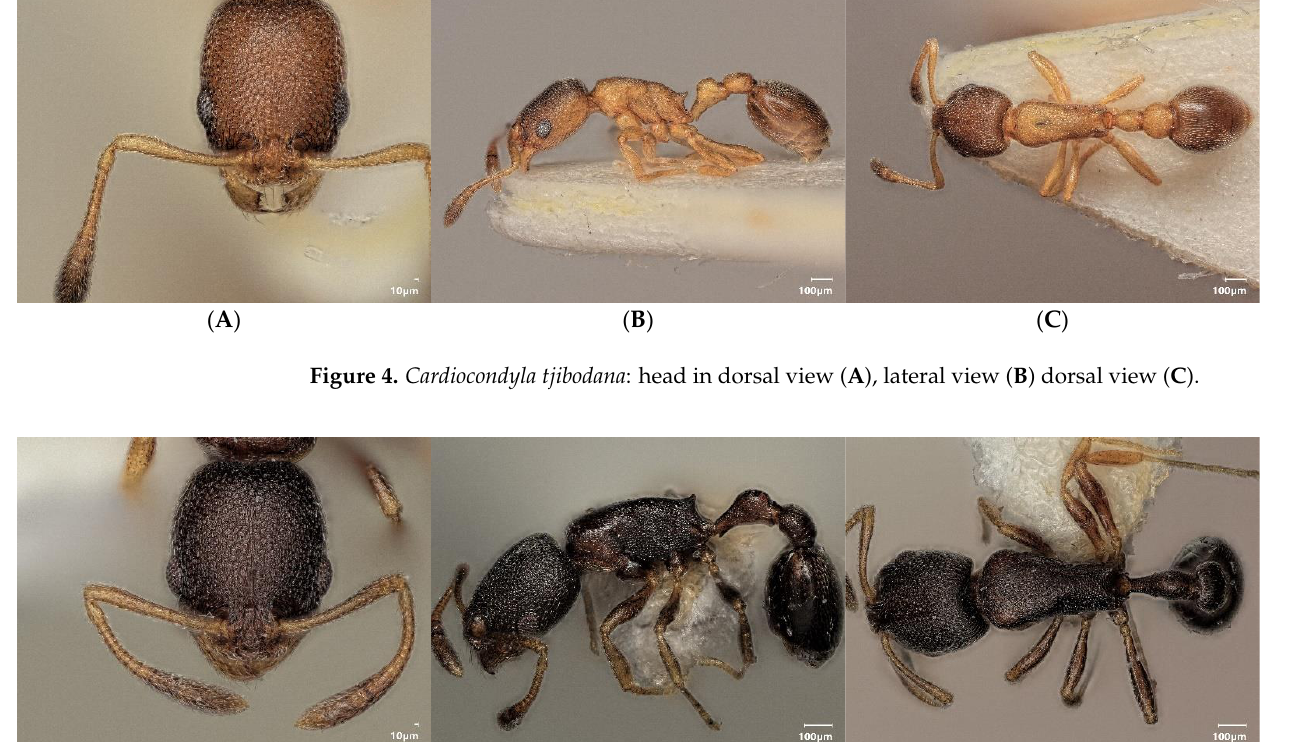
Figure 5. Cardiocondyla schulzi , holotype: head in dorsal view ( A ), lateral view ( B ), dorsal view ( C ).